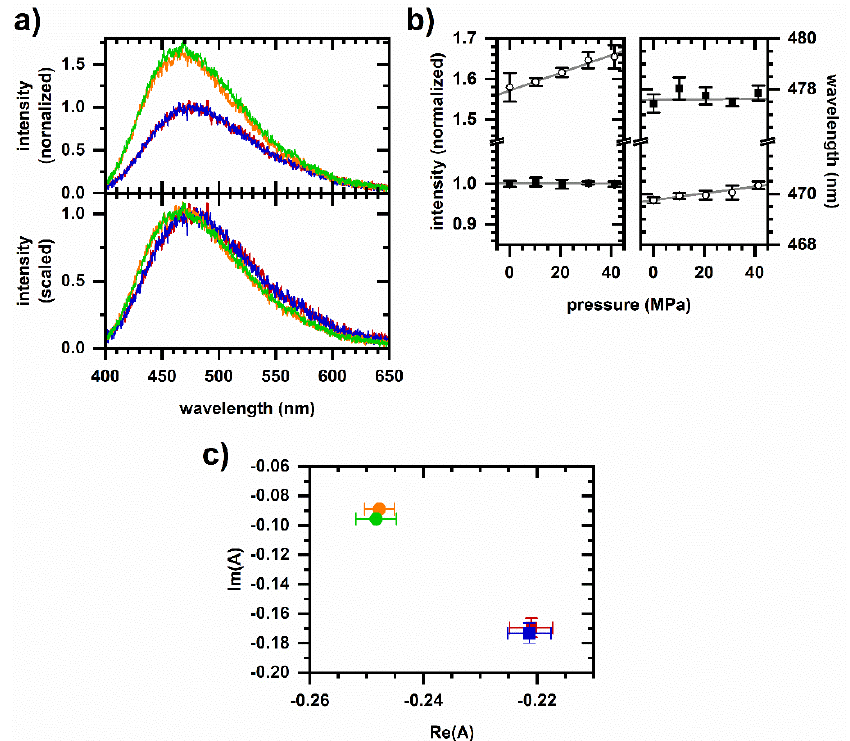
Figure 3. Excited-state emission from NADH in solution under pressurized conditions. ( a ) Emission spectra for 40 µM NADH in 0 vol% methanol (red, 0.1 MPa; blue, 41.4 MPa) and 90 vol% methanol (orange, 0.1 MPa; green, 41.4 MPa). Top, spectra are normalized to the peak intensity of the 0 vol% methanol, ambient pressure spectrum. Bottom, spectra are scaled to minimize least-squares differences. ( b ) Peak intensity and peak-intensity wavelength of emission from 0 vol% methanol (solid square) and 90 vol% methanol (open circle) samples. Values are from a Gaussian fit to a 75 nm wavelength interval roughly centered on the spectrum peak. Error bars are the standard deviation of repeated measurements which include spectra taken during both the pressurization and depressurization legs of a data run. Least-squares linear fits are shown in gray. ( c ) Phasor plot. Symbol color corresponds to the same conditions as in Figure 3a. Phasors are calculated over the first 512 pixels (400–530 nm wavelength).